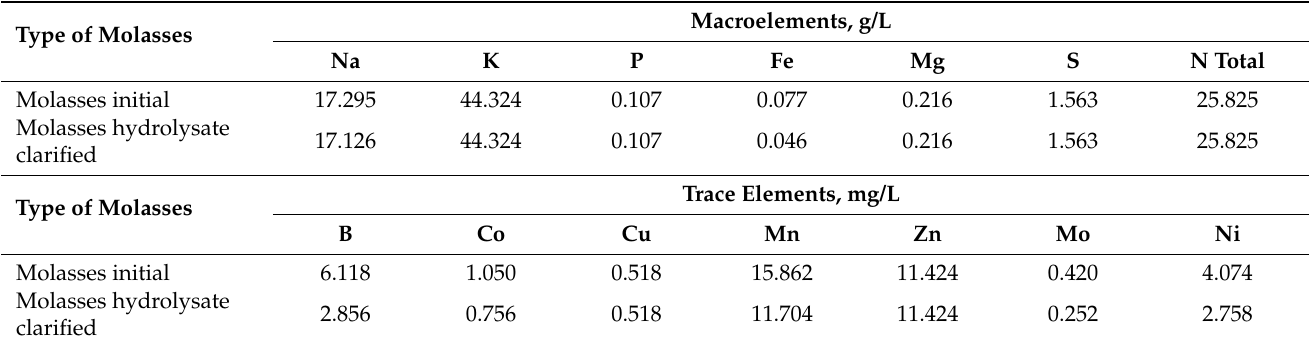
Table 2. Chemical composition of sugar beet molasses and the resulting